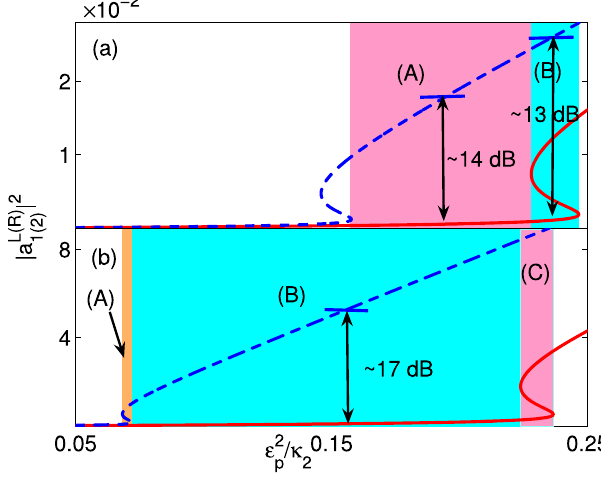
2 (red solid 2 2 with ( a ) γ = 0.15 κ 2 , g = 2 κ 2 , Δ 1 = Δ 2 = 0, p 2 = 2 κ Δ = Δ = 0, κ = − 7.4 κ γ = 0.17 κ 2 , g 2 , 1 2 1 2 ,